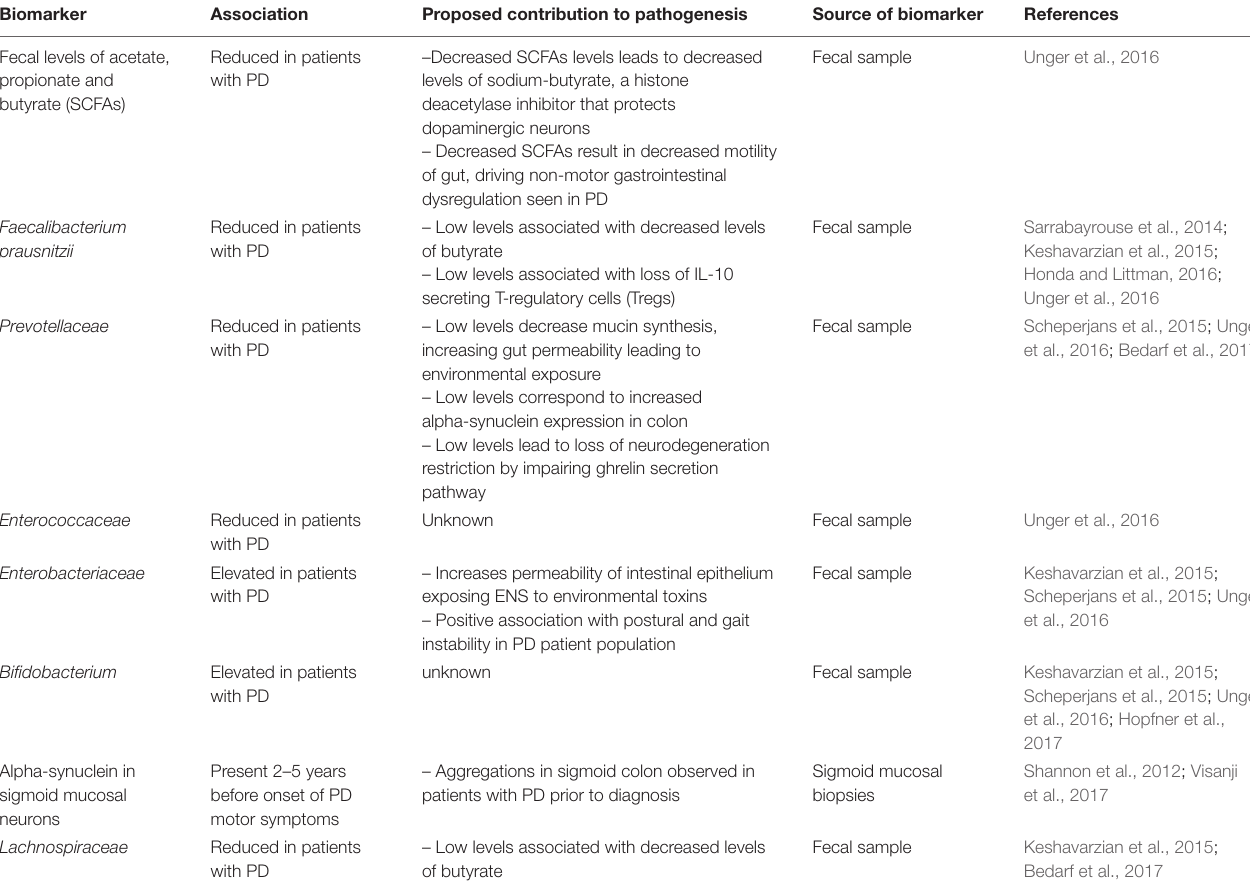
TABLE 1 | Potential targets for the development of future biomarkers in measuring the progression of pathology in Parkinson’s disease